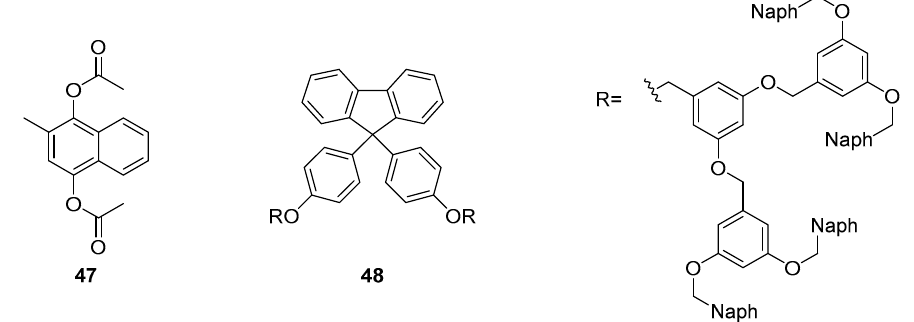
Figure 20. Vitamin K4 47 is the substrate for dendrimeric probe 48 , which reports its presence with a 13-fold increase in the fluorescence emission at 340 nm. This is thought to arise via intermolecular energy transfer from the naphthalene branches of 48 to the aromatic target 47 , which is held within the naphthalene branches by π – π interactions. (Naph = 1-naphthalenyl) [122].